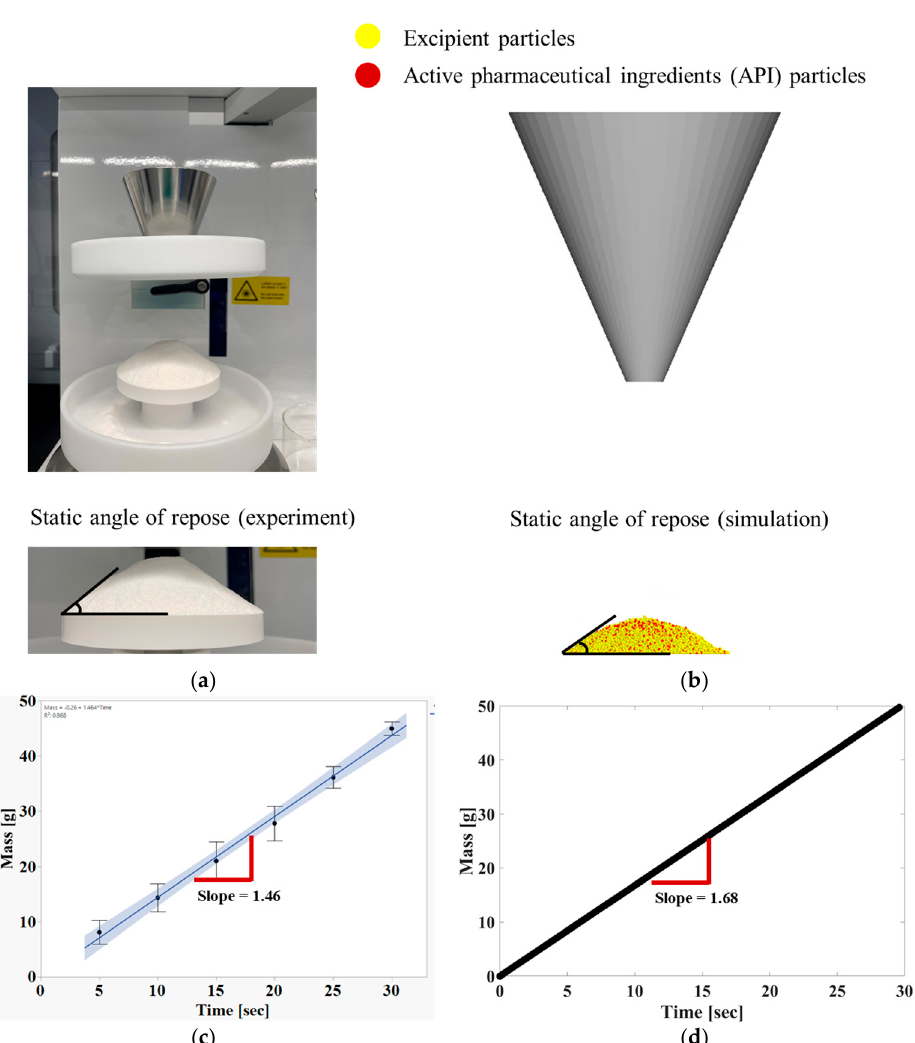
Figure 1. Particle calibration using angle of repose and mass flow rate experiment: ( a ) Experimental setup using Erweka GTB Granulate; ( b ) DEM simulation set up; ( c ) Mass flow measured through the experiment; ( d ) Mass flow measured through the DEM simulation. Table 2. Powder material properties and simulation parameters used in the DEM simulations.